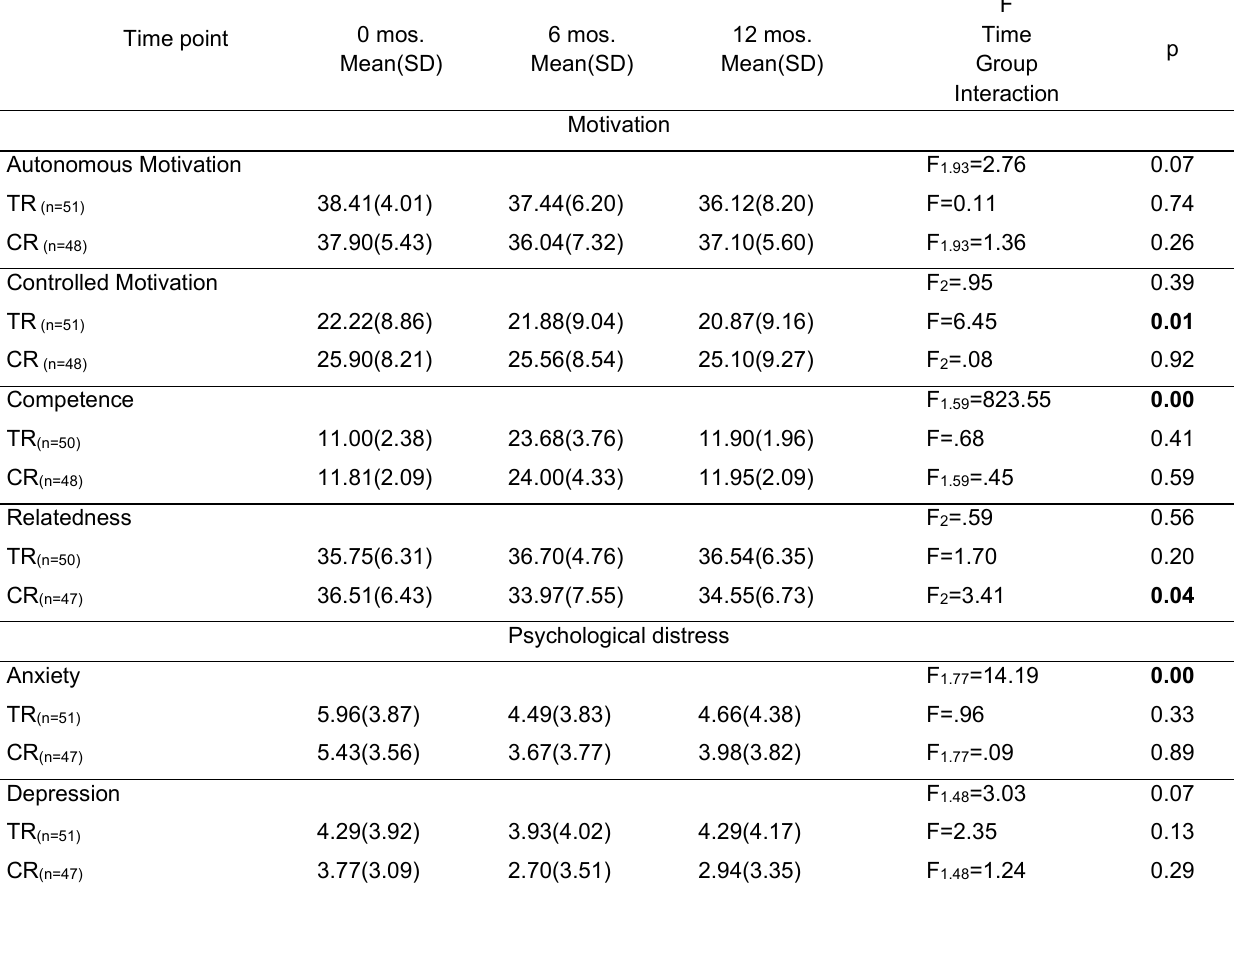
Results of Unadjusted Analyses for All Outcome Measures over